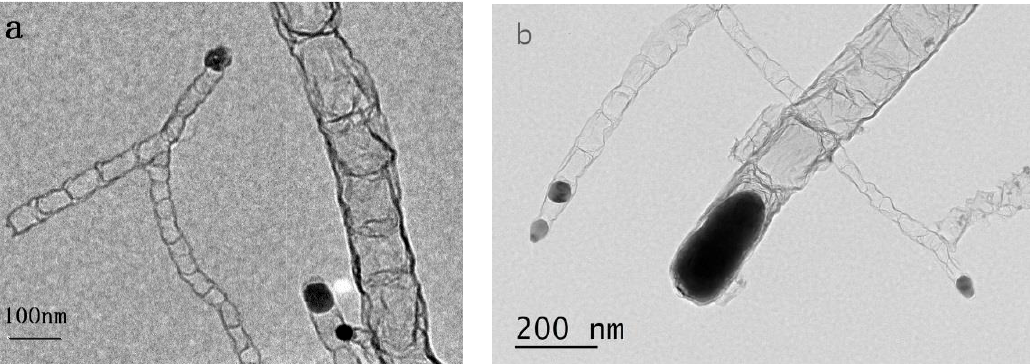
Figure 1. Transmission electron microscopy (TEM) images of the cobalt species and polymer of N-doped carbon nanotubes: ( a ) CoO x –NDCNTs and ( b ) Co–NDCNTs.